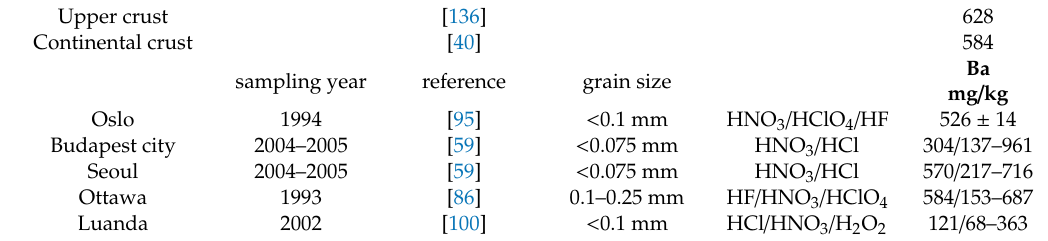
Table A25. Barium in road